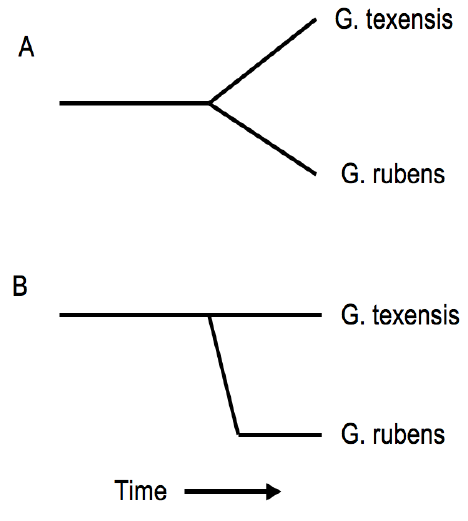
Figure 7. Contrasting models of speciation. Figure 7a shows the classical gradualist model with divergence attributable to approximately equal changes in both sister lineages; Figure 7b shows a punctuational view of species formation, with the majority of divergence attributable to rapid change within one ‘daughter’ lineage and relatively little change within the ‘parental’ lineage. Currently available molecular data favor a peripatric ‘puctuational’ origin of G. rubens